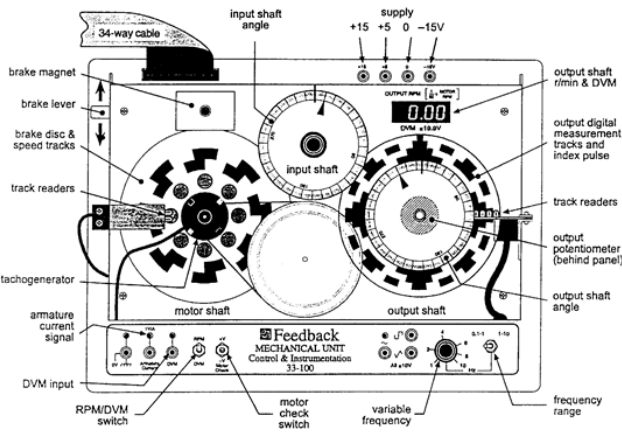
Fig. 1. Feedback Mechanical Unit Model